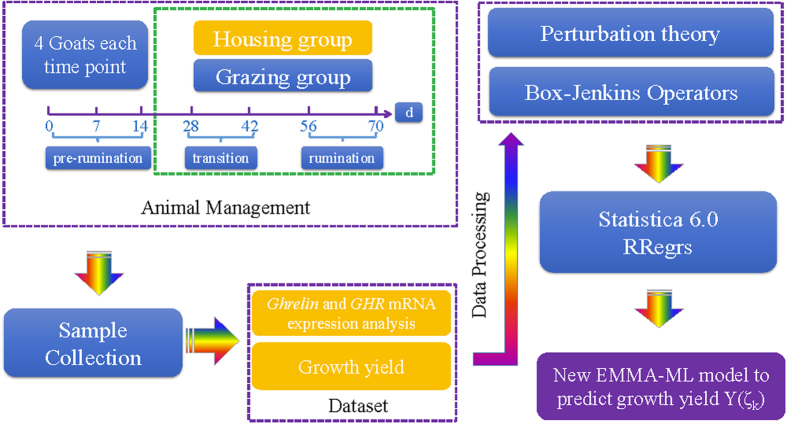
Flow chart of experimental and theoretical sections for Y(ζk) predictive models.